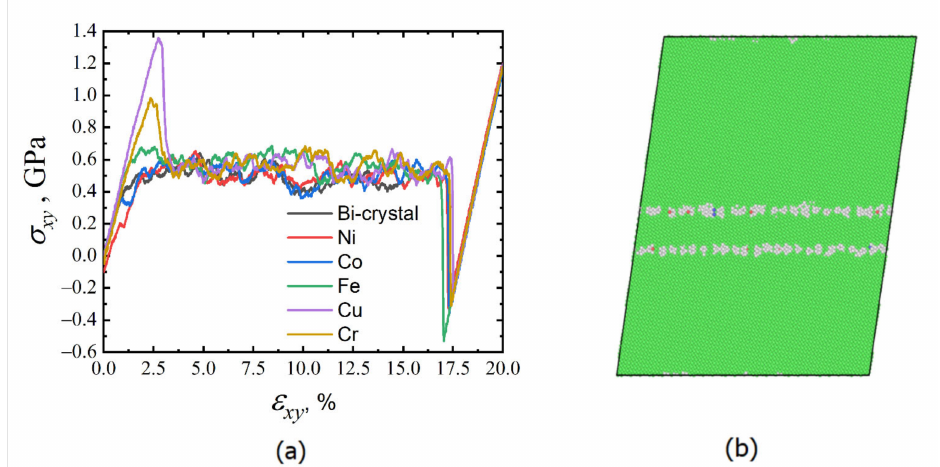
Figure 2. ( a ) The shear stress–strain curves for the considered bicrystals. The corresponding type of segregated element is indicated in the legend for each bicrystal, while the case without GB segregation is denoted as Bicrystal. ( b ) Structure of the bicrystal with GB segregation of Cr at 12% shear